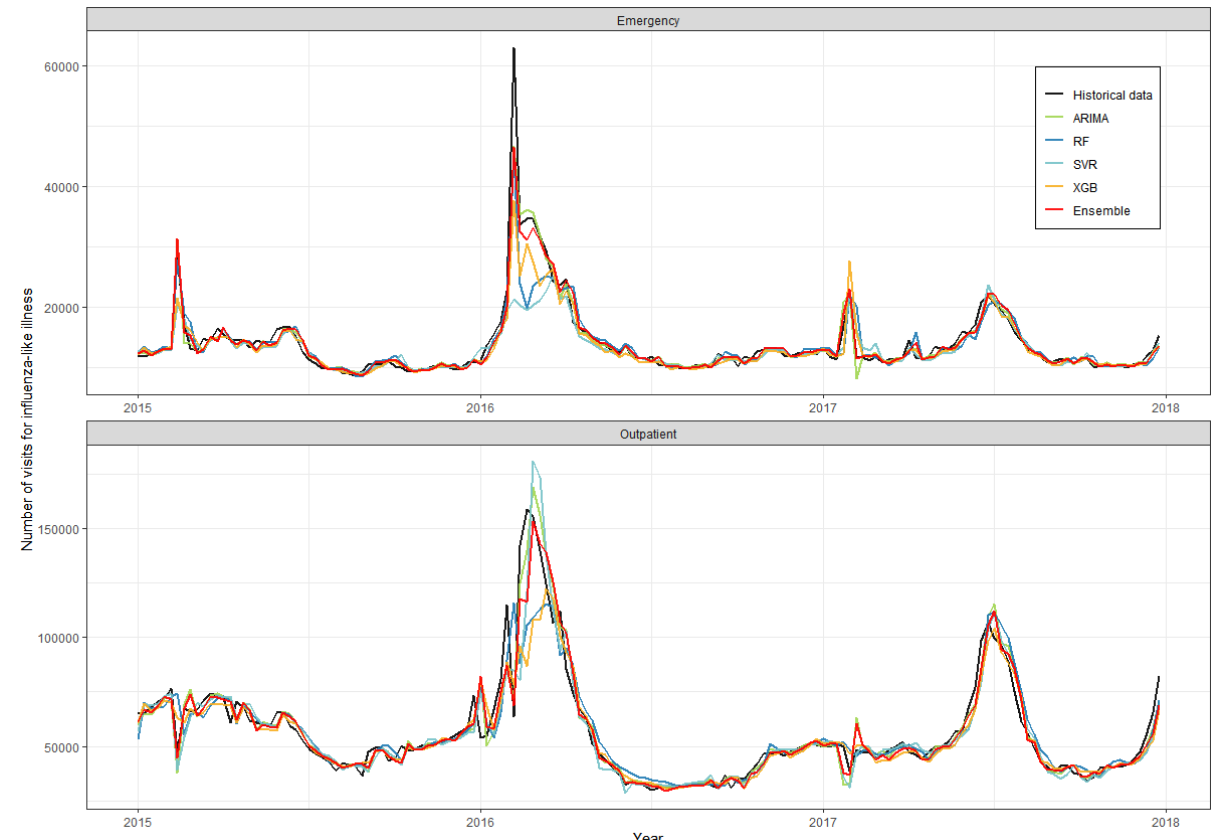
Figure 3. Nowcasts (current week predictions) of the influenza-like illness visits in outpatient and emergency departments by the 5 machine learning models (colored lines) compared with the observed historical data (black line), 2015-2017. ARIMA: autoregressive integrated moving average; ILI: influenza-like illness; RF: random forest; SVR: support vector regression; XGB: extreme gradient